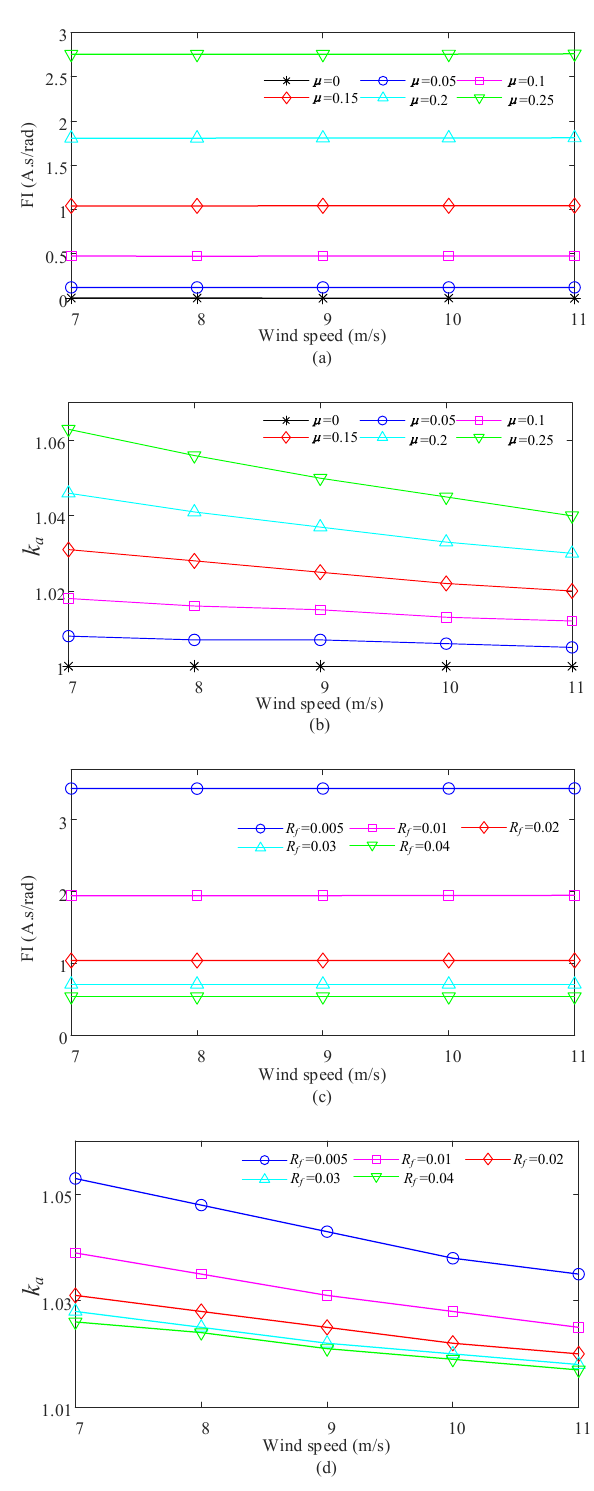
Figure 10. Fault detection index and fault phase location index under different wind speeds. ( a ) Detection index FI with different μ ; ( b ) location index k a with different μ ; ( c ) detection index FI with different R f ; ( d ) location index k a with different R f .